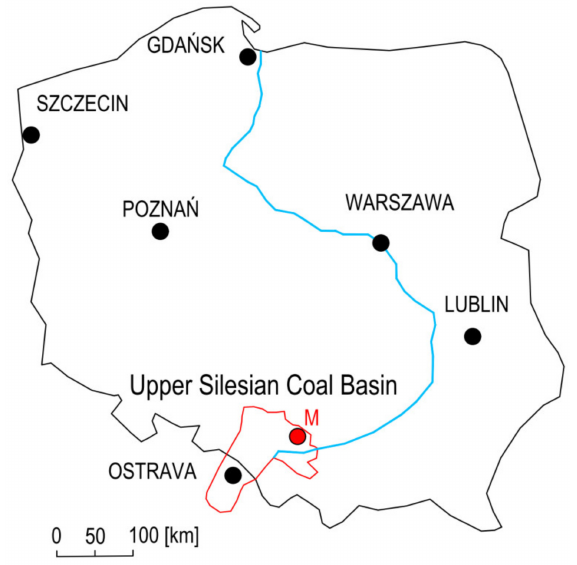
Figure 6. Location of the research area on the map of